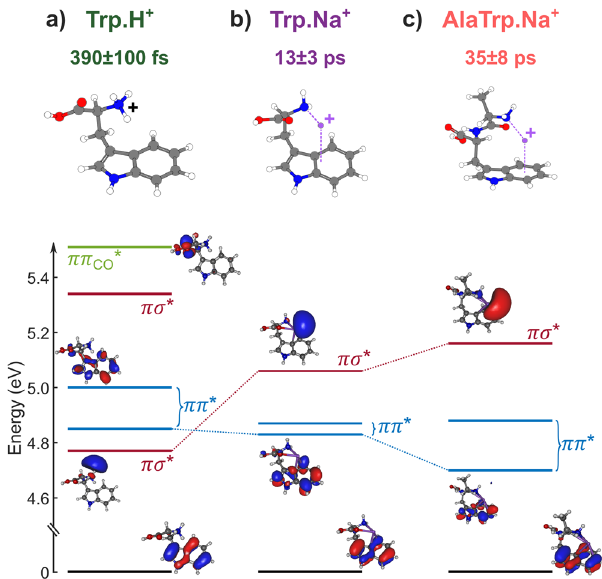
Fig. 3 Excited electronic states in tryptophan-containing charged peptides. Calculated vertical excited states for TrpH + ( a ), TrpNa + ( b ), and AlaTrpNa + ( c ), together with their equilibrium geometry (on top). The corresponding dominant orbitals are also displayed, giving the state- character of the excited state ( πσ * states in red, ππ * states in blue, ππ CO * state in green, with the ground state being in dark). Changing the adduct atom (from a ) to b )) or changing the molecular backbone (from b) to c)) has a different in fl uence on the position of the πσ * states and ππ * states.